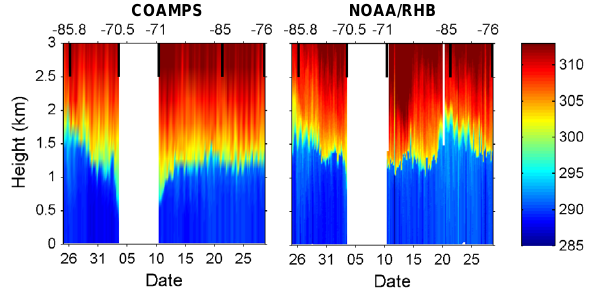
Fig. 6. Time-height cross-section of potential temperature ( θ ) from the COAMPS fore- casts (left) and the RHB rawindsondes (right). The analysis covers the period of 25 October through 29 November 2008. The numbers at the upper axis with the heavy vertical lines denote the longitudes of the most western and eastern locations of the RHB cruise for each leg during this period. No data were collected November 3-10 between the two cruise legs.